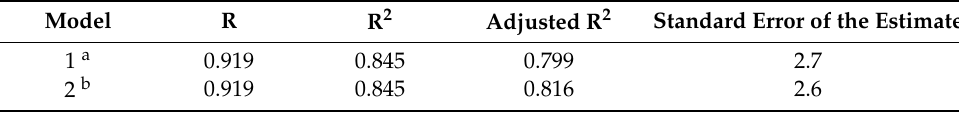
Table 5. Model summary (stepwise method).